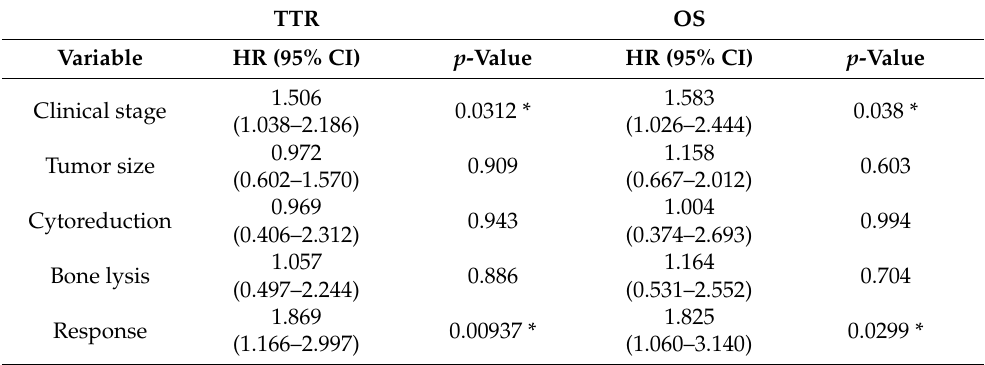
Figure 3. Kaplan–Meier survival curves of the dogs with oral melanoma, evaluated on the basis of the presence of bone lysis, ( a ) with bone lysis ( n = 39) and without bone lysis ( n = 29)); and the response to radiation therapy ( b ) SD ( n = 19), PR ( n = 23), and CR ( n = 26)). Significant differences were observed between the groups in brackets. ** p < 0.01. Table 2. Multivariate Cox proportional hazards regression analysis of predictive